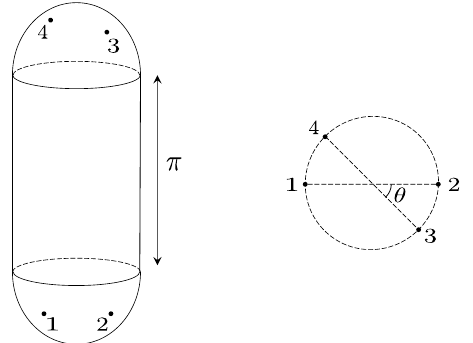
Figure 3. A ‘cylinder with caps’ configuration discussed in [17]. We consider two Euclidean hemispheres and connect them by a Lorentzian cylinder of length π . We then insert two operators on the upper cap and the remaining two operator on the lower cap. The right figure shows a configuration of operator when viewed from the bottom of the lower cap. The angle θ depicted in the figure becomes a scattering angle in the flat-space